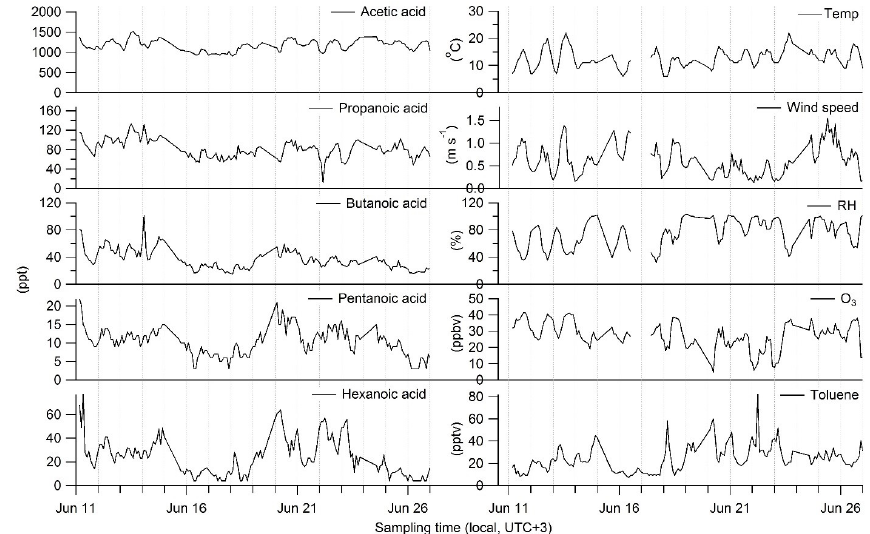
Figure 1. Mixing ratios (pptv) of volatile organic acids (C 2 –C 6 ) and trace gases together with meteorological parameters at SMEAR II station in Hyytiälä, Finland.